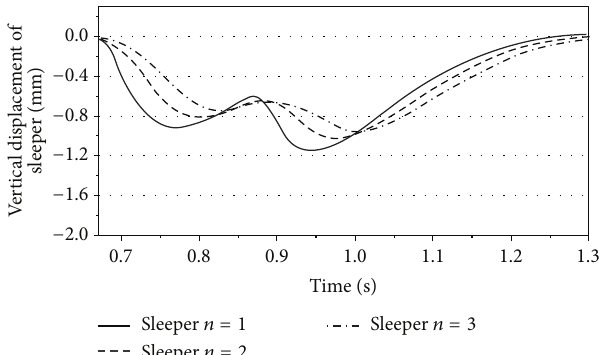
Figure 7: Vertical displacement of the sleepers with double-point fastening during motion in the zone behind the rigid base.